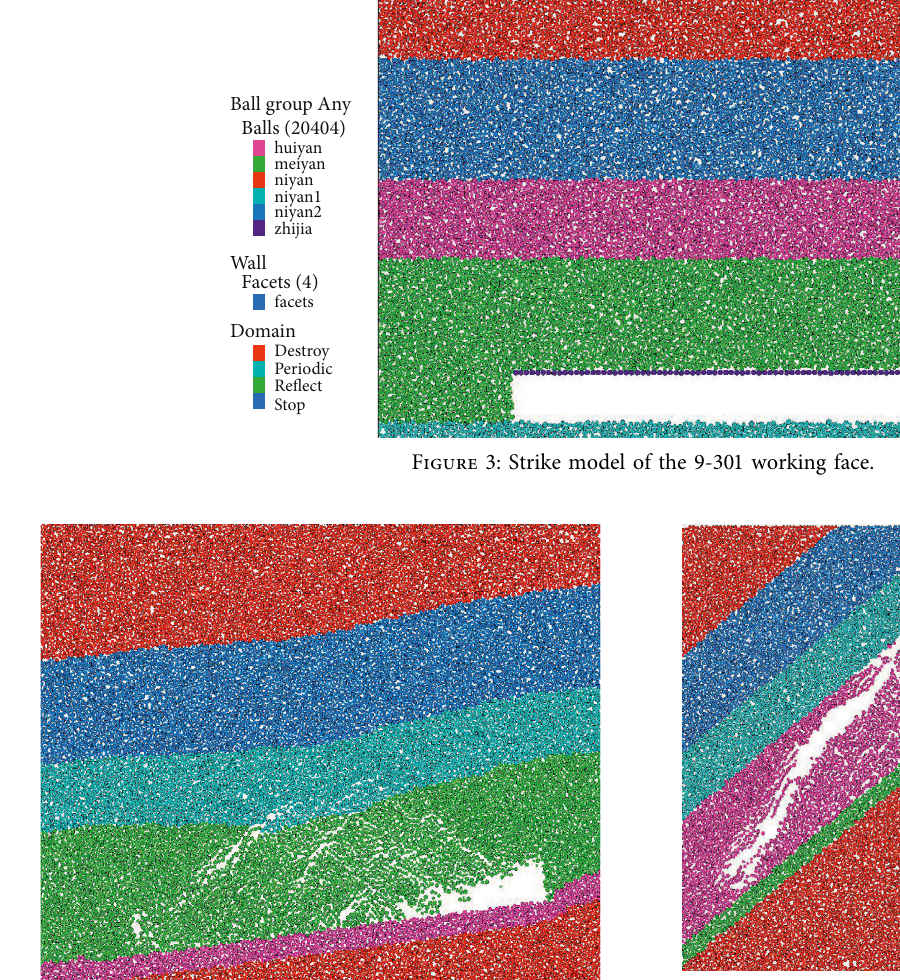
Figure 6: Effect of the coal seam’s dip angle (35 ° ) on coal